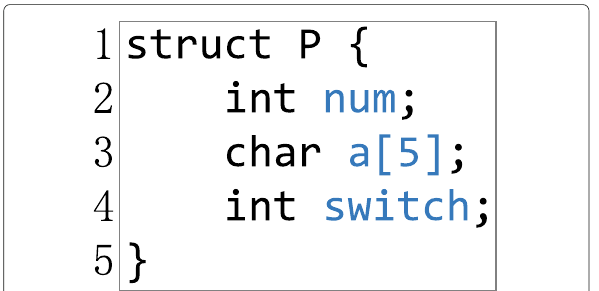
Fig. 11 An data structure showing first